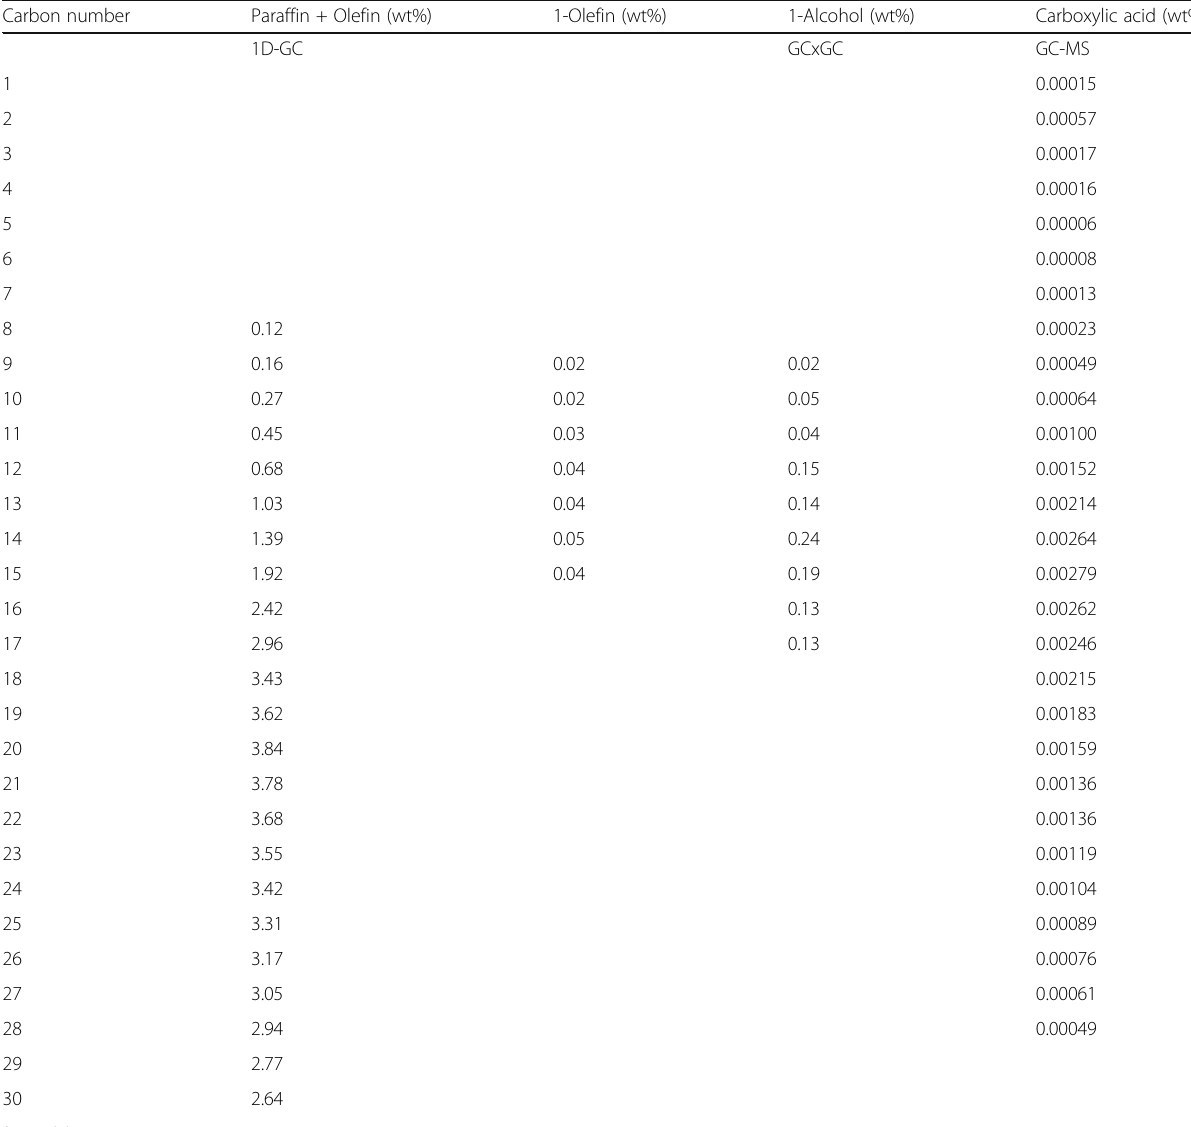
Table 5 Summary of 1D-GC, GCxGC and GC-MS analyses, Wax1 Carbon